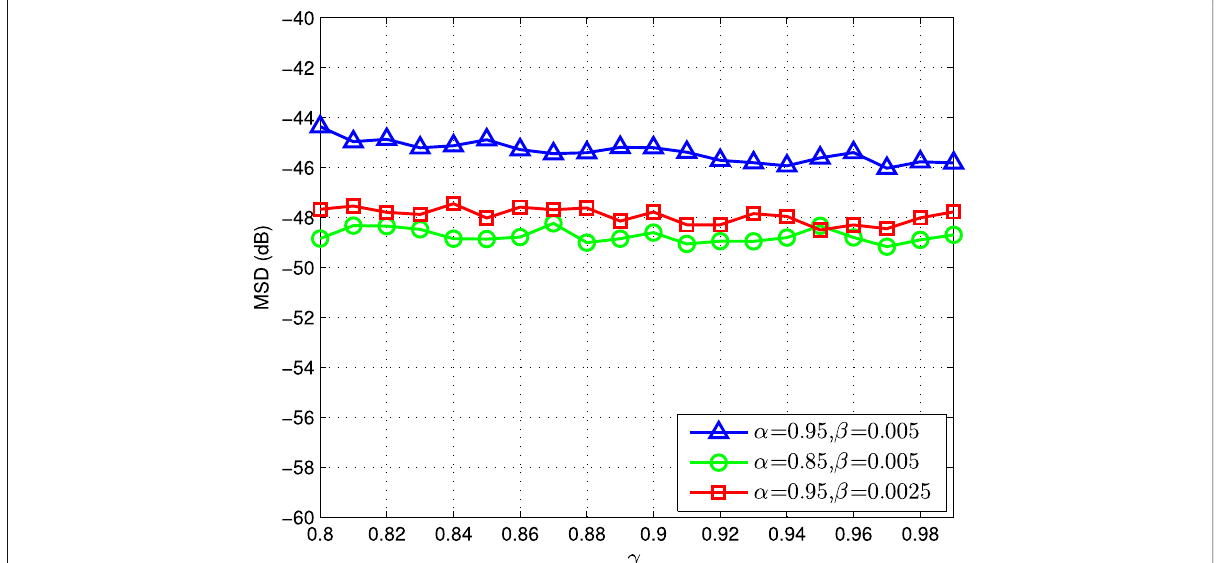
Fig. 5 Steady-state MSD versus γ for different values of α and β for the LCTVFF